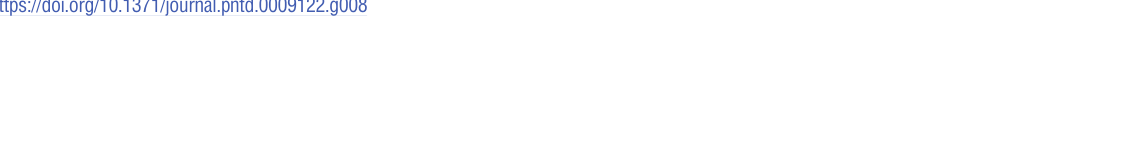
PLOS NeglectedTropical Diseases | https://doi.org/10.1371/journal.pntd.0009122 March 8,